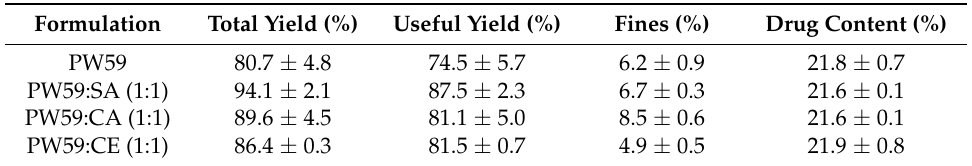
Table 3. Yields and drug content of microparticles produced from different drug-loaded formulations spray-congealed under similar conditions (0.3 bar pressure, 25% airflow, atomizing air temperature 10 ◦ C above peak melting temperature of material, n = 3). Formulation Total Yield